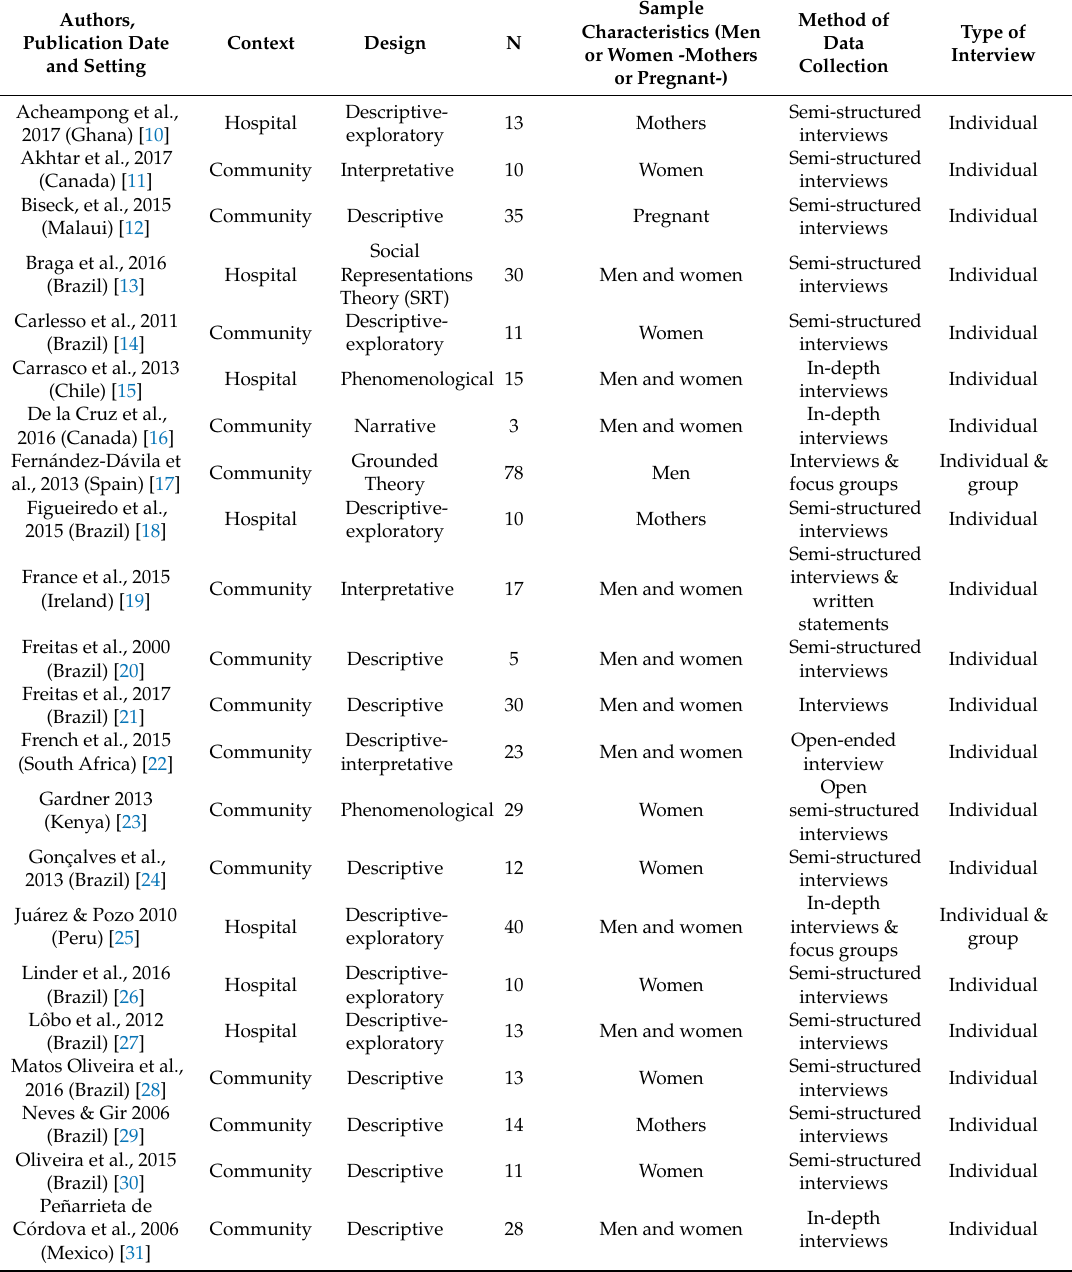
Table 1. Summary of studies included in the review and narrative